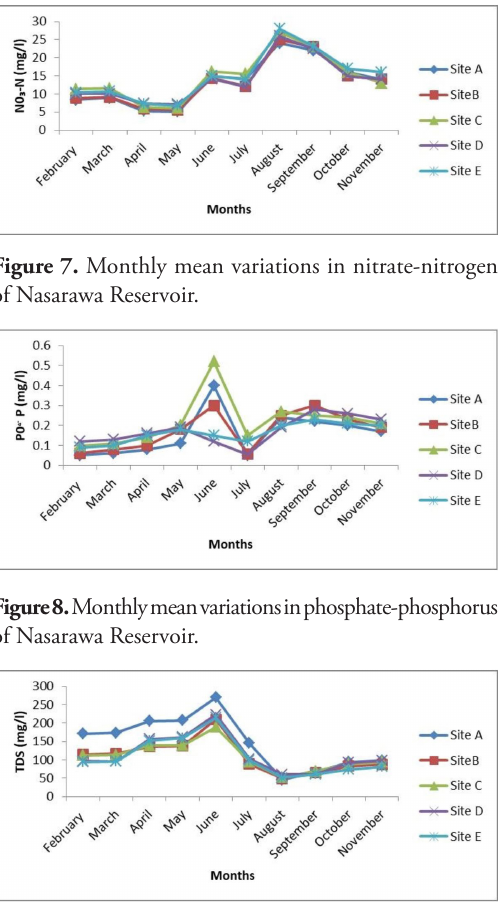
Figure 9. Monthly mean variations in total dissolved solids (TDS) of Nasarawa